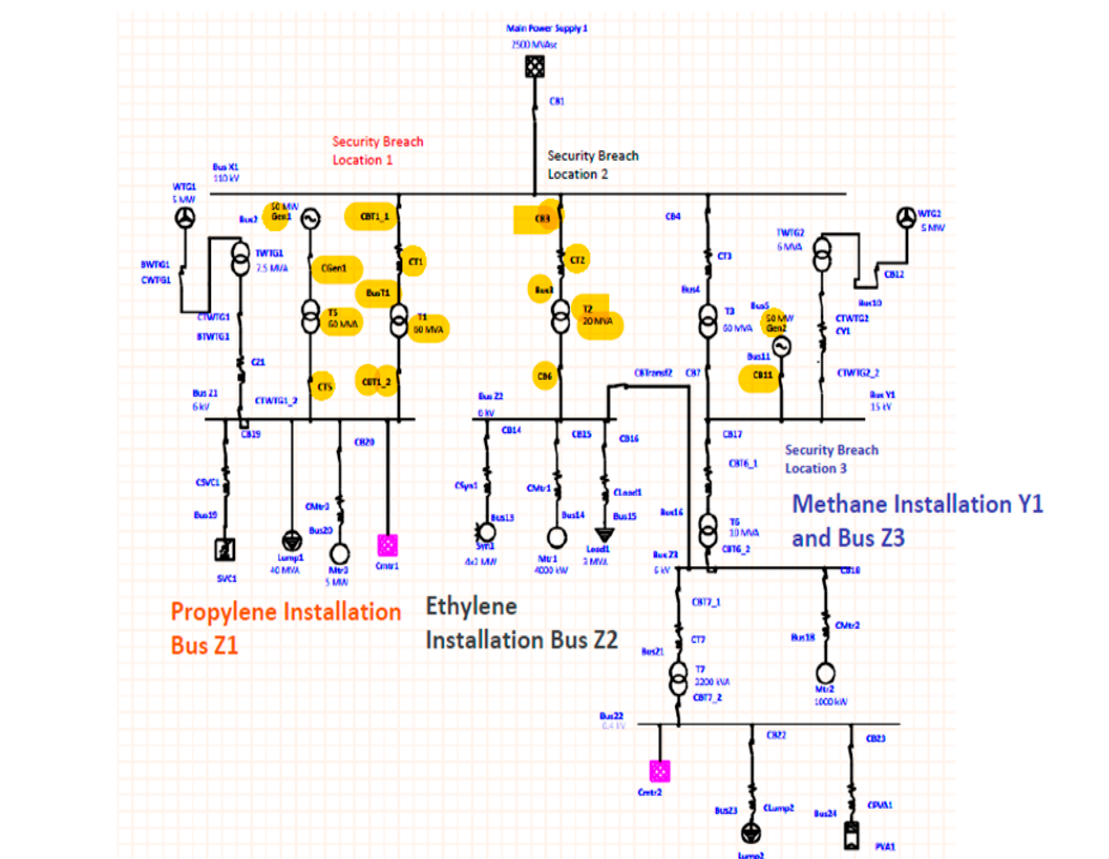
Figure 3. Full plant installation highlighting possible security breaches.